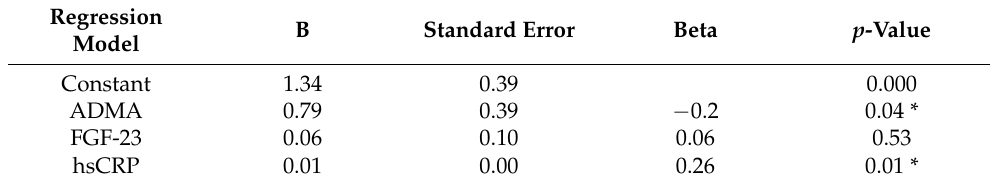
Table 4. The prevalence of elevated ADMA and hs-CRP depending on DM diagnosis.